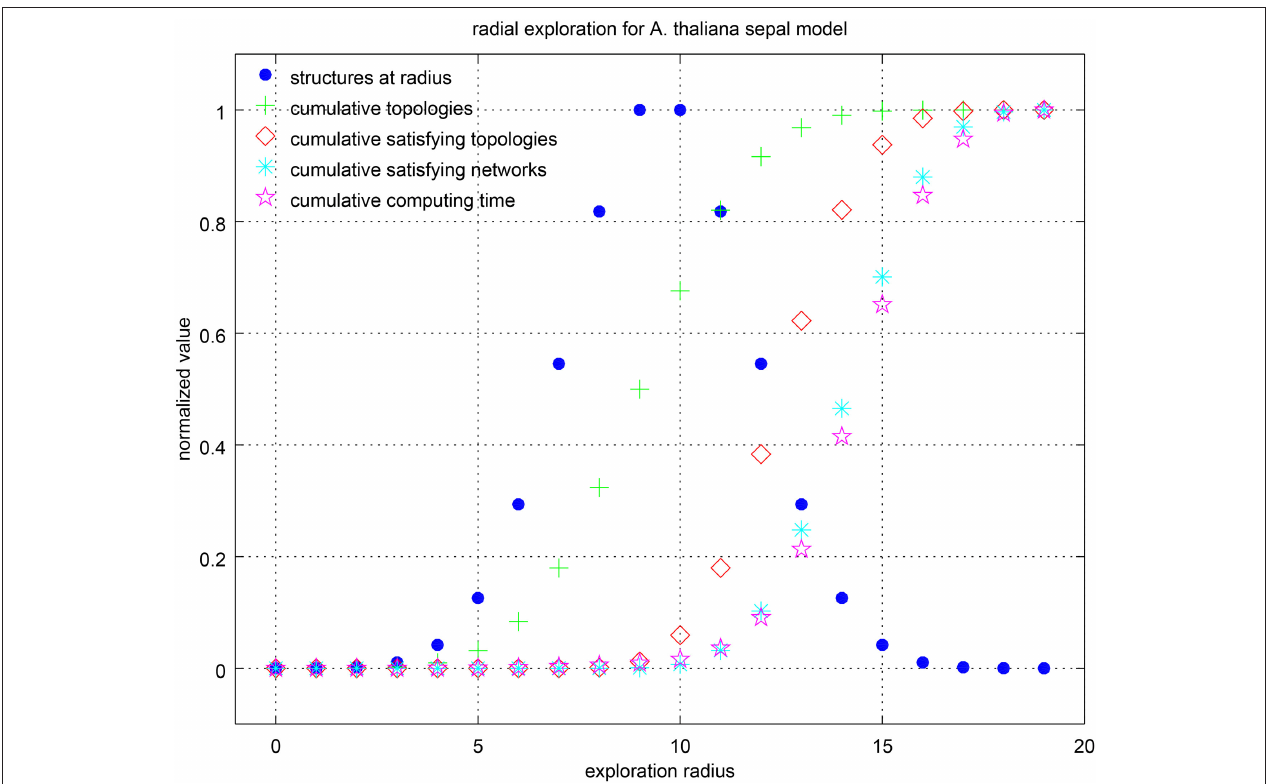
FIGURE 8 | Center-radius exploration strategy for the sepal model. Values have been normalized by their maximum in each category. The number of R-graphs grows rapidly with the radius. It is given by the binomial coefficient correlated with the number of cumulative satisfying